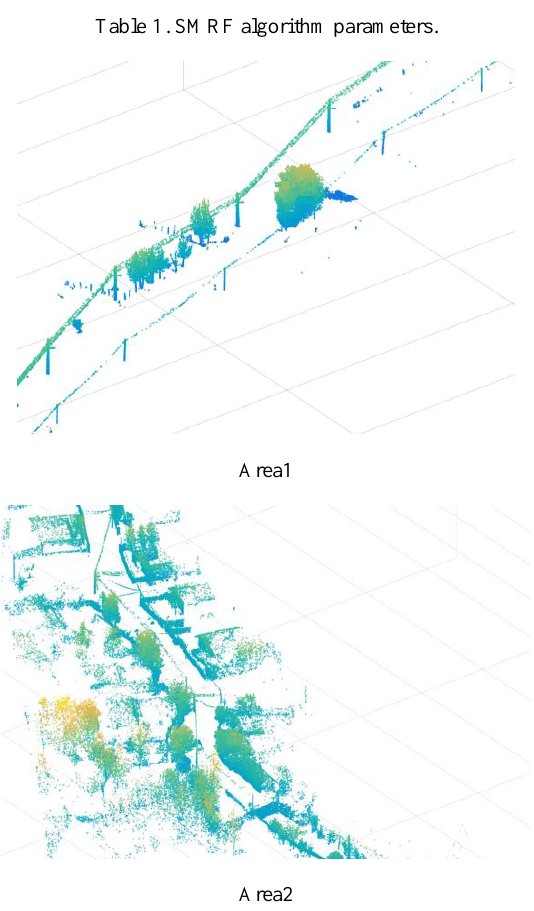
Figure 4. Non-ground points generated using